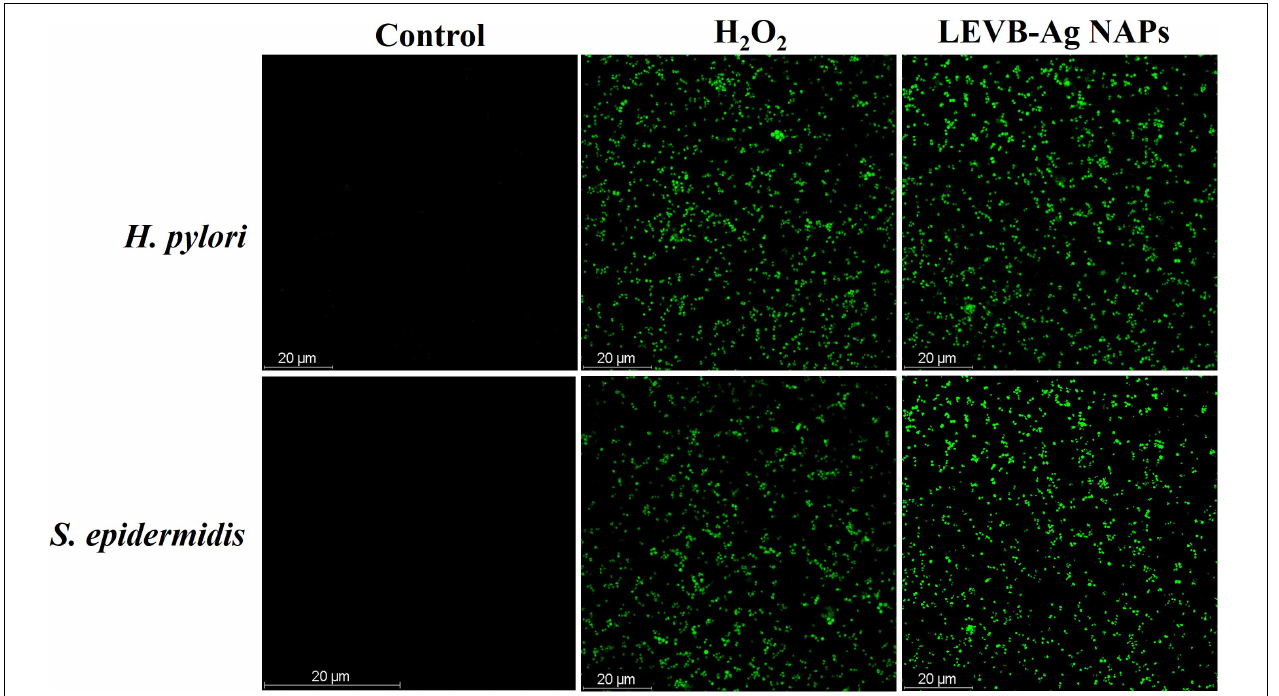
FIGURE 5 | ROS generation in untreated (control), LEVB-Ag NAPs, and H 2 O 2 treated Gram-positive and Gram-negative bacterial strains.